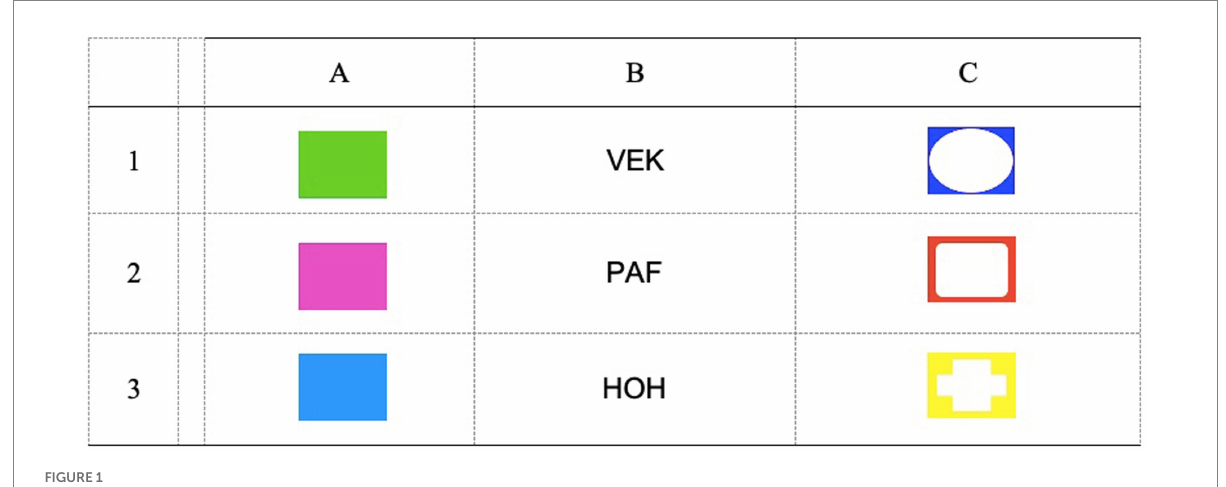
FIGURE 1 Stimuli used during the experimental